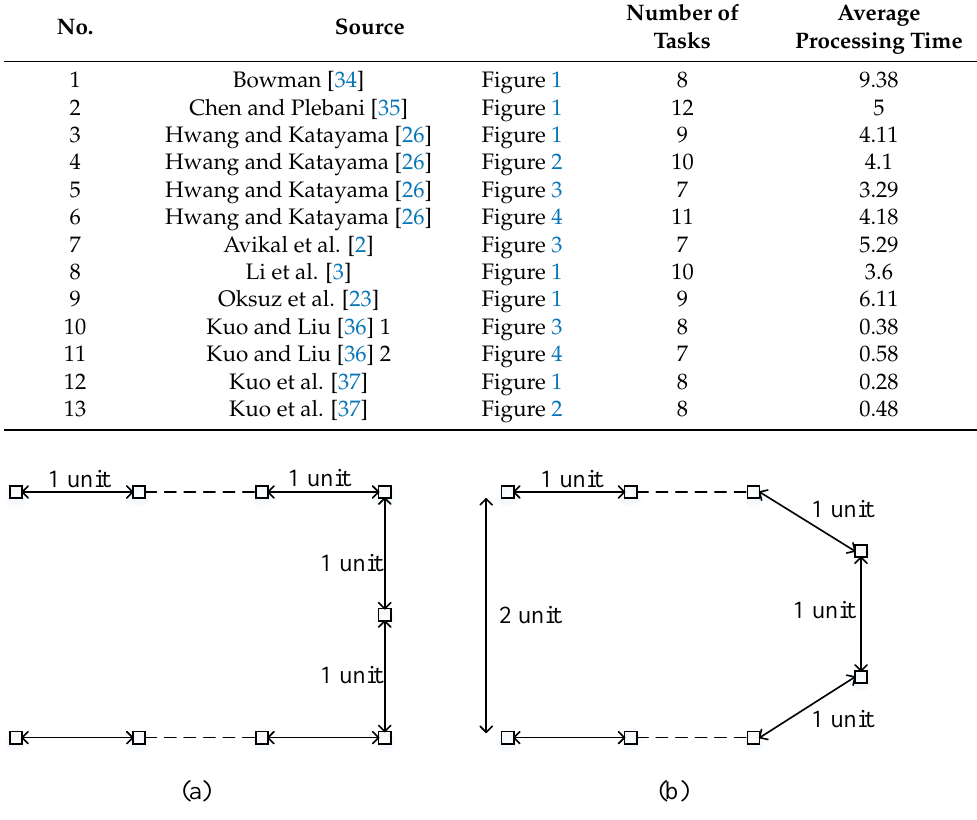
Figure 8. Layout of the U-shaped assembly cells. ( a ): Number of tasks is odd; ( b ): Number of tasks is